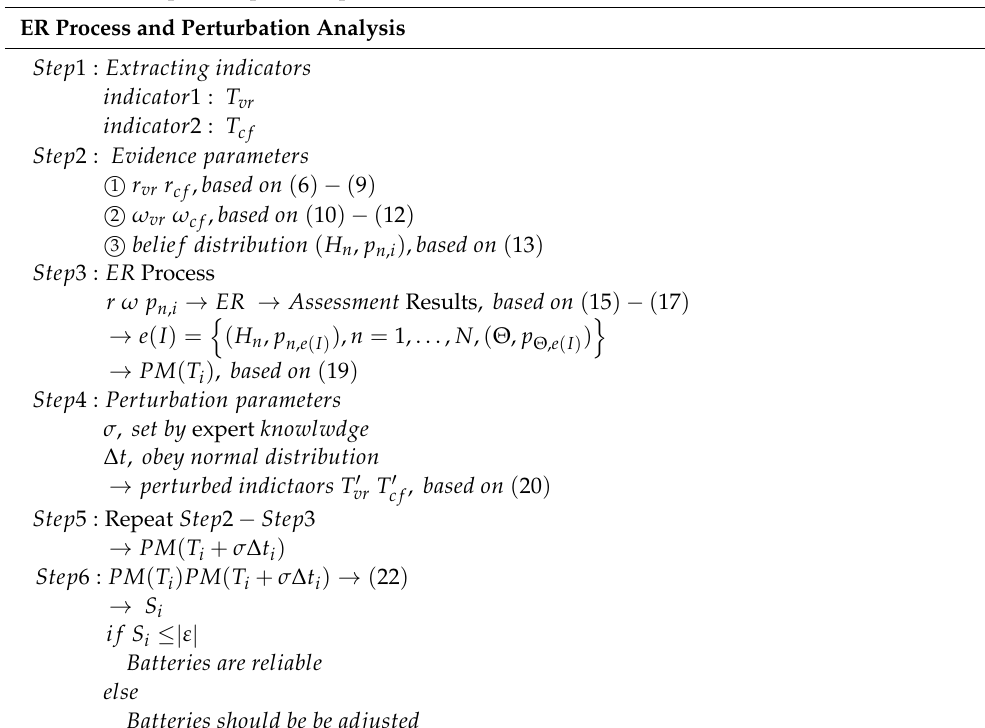
Algorithm 1. Specific operation process of the